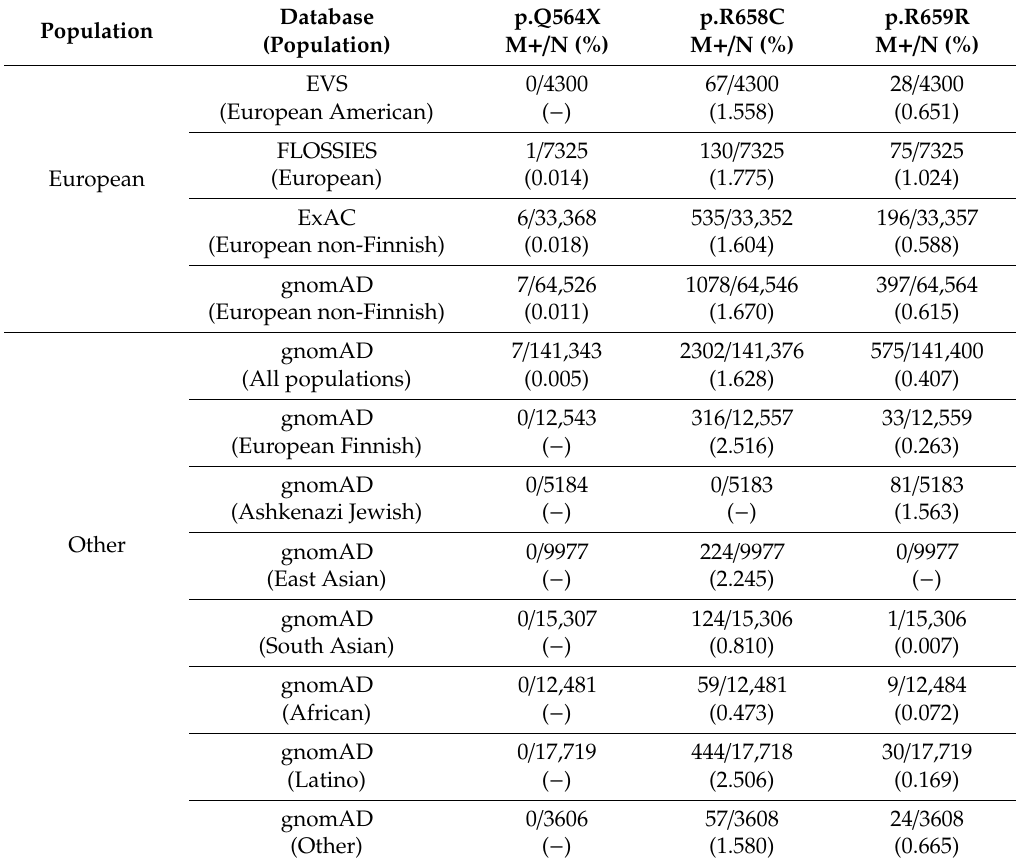
Table 1. The frequencies of selected BARD1 variants in European and other